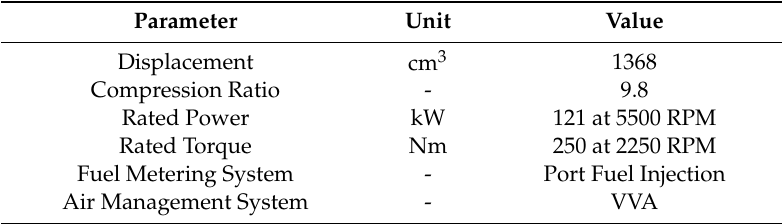
Table 2. Main technical specifications for the reference